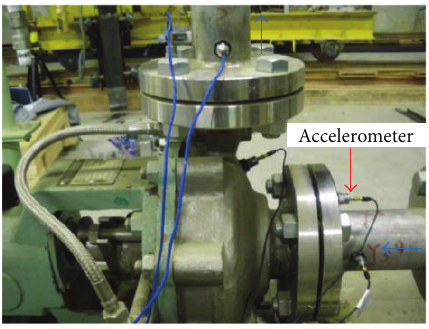
Figure 3: The location of